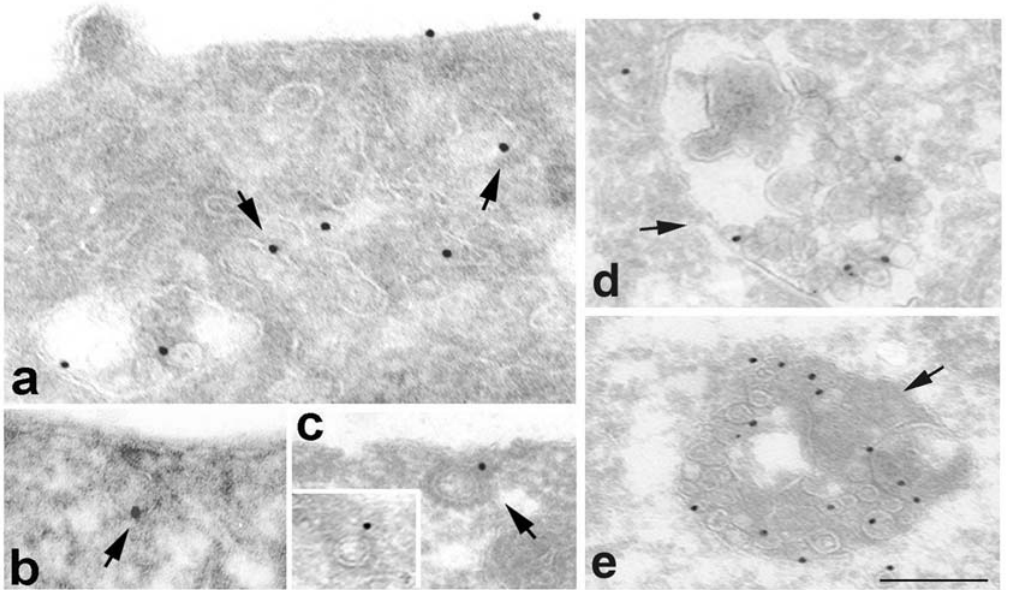
Figure 4. PrP C internalization by electron microscopy analysis. ( a–c ): Immunogold labeling of PrP C on ultrathin cryosections of FRT cells under steady-state culture conditions reveals that PrP C (15 nm gold) is localized within both smooth and morphologically identified clathrin-coated pits; (d–e) FRT cells have been incubated 30 min on ice in the presence of antibody against PrP. After 30 min incubation at 37 u C the cells were fixed and processed for cryo ultramicrotomy. Ultrathin cryosections were immunogold labeled using protein A-gold (15 nm). As shown also in the absence of a possible surface cross-linking of the two antibodies due to the protein A, PrP C reaches the endosomal compartments. Bar: a =235 nm; b =245 nm; c =215 nm; d,e =263 nm. Arrows point to the different intracellular compartments labelled with a PrP antibodies. Morphometric analysis on 1800 total gold particles revealed n=0 PrP gold particles in flask-shaped structures and n=25 in clathrin-coated pits.